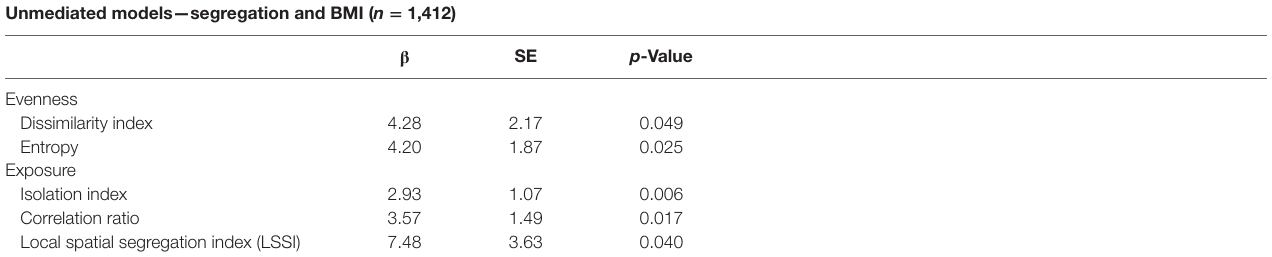
TaBle 2 | Multi-level regression estimates of association of residential racial segregation and body mass index (BMI), with and without mediation by food environment. Unmediated models—segregation and BMi ( n = 1,412) β se p -Value